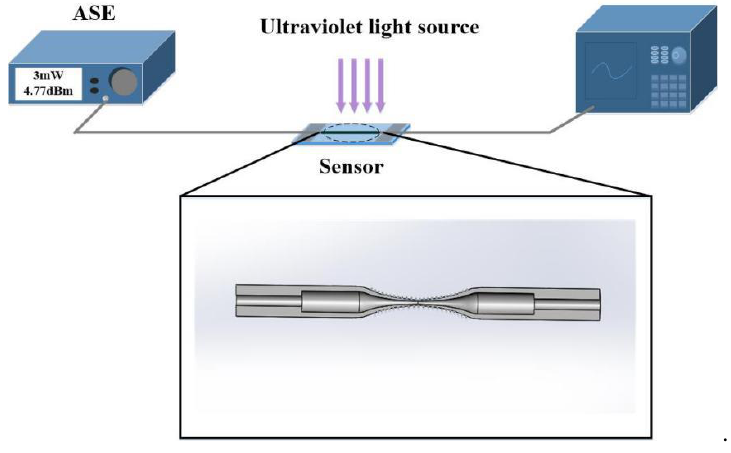
Figure 1. Schematic diagram of the experimental setup.